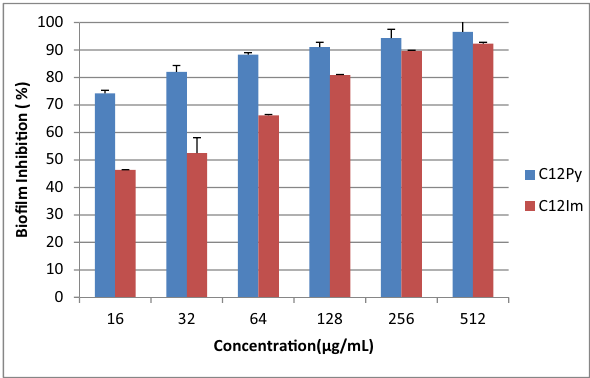
Figure 6: Inhibitory activity of C12 NPs at di ff erent concentrations against the bio fi lm formation of Enterococcus faecalis in 24 h.